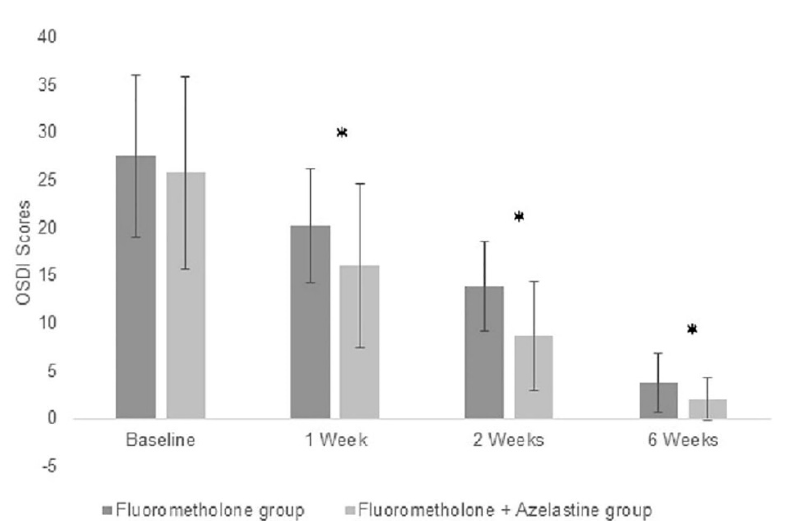
Figure 2. Improvement of OSDI scores with topical fluorometholone alone or combined with azelas- tine at baseline. * p < 0.05 compared between group. OSDI = Ocular Surface Disease Index.